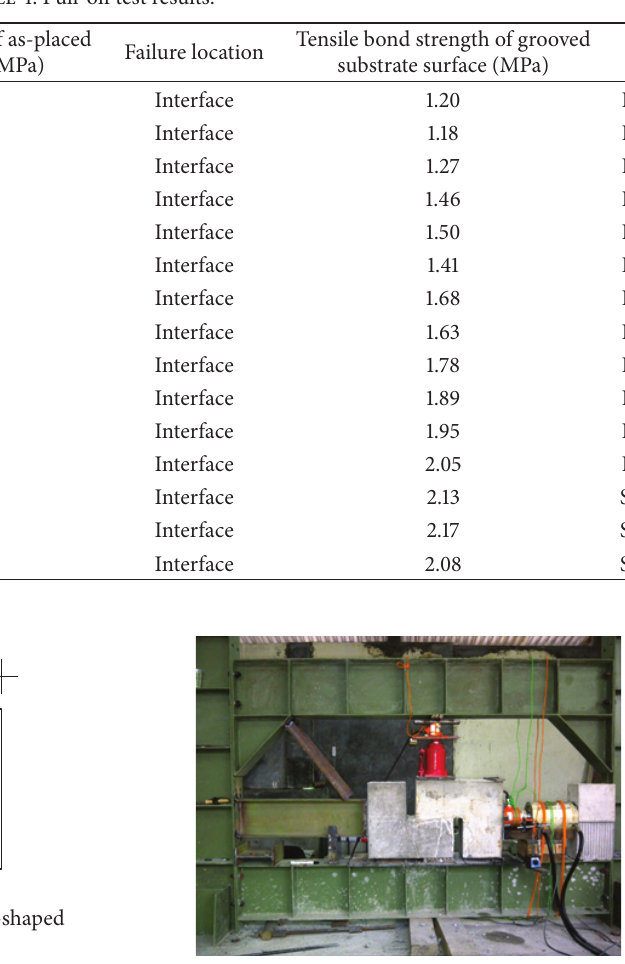
Figure 5: Double L-shaped shear